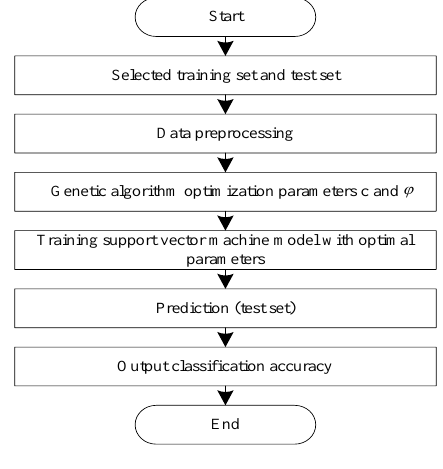
Fig 2. Optimization of support vector machine parameters by genetic